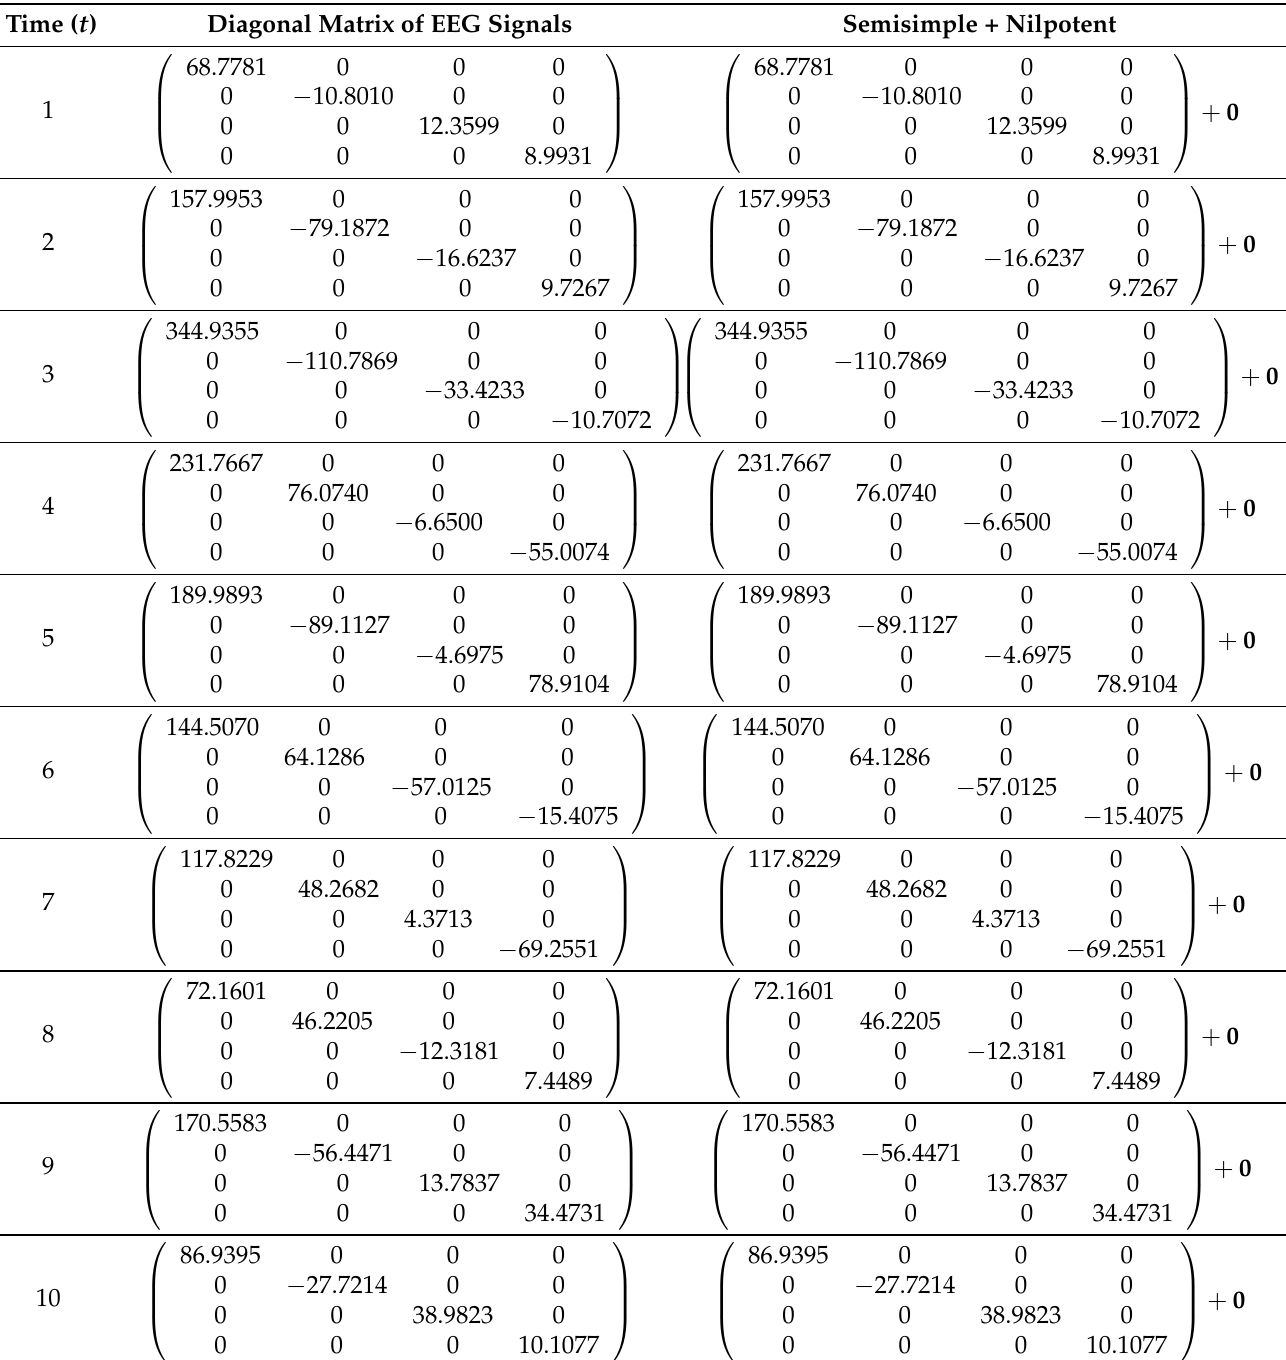
Table 7. Diagonal matrix of EEG signals of Patient A at time t = 1 to t = 15 written as a summation of their respective semisimple and nilpotent